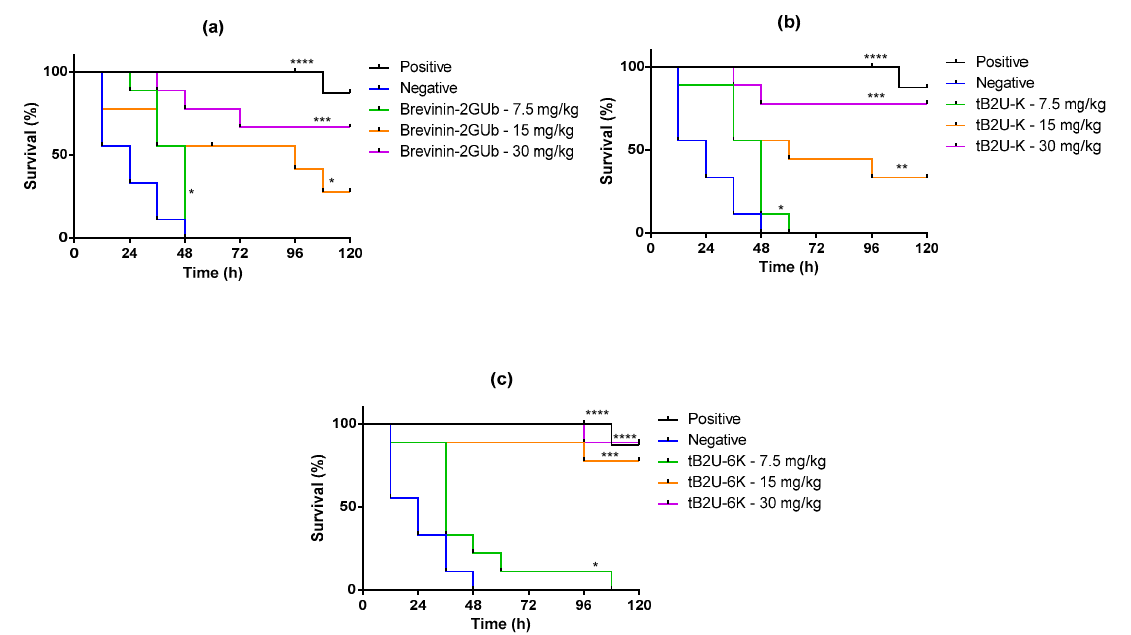
Figure 9. The curves of survival of ( a ) Brevinin-2GUb, ( b ) tB2U-K, and ( c ) tB2U-6K in wax moth infected by E. coli . The PBS and 20 mg/kg norfloxacin are selected as the negative and positive controls, respectively. The data were analysed by the survival analysis and curve comparison test comparing the survival rate of different concentrations of peptides with that of the negative control group. The significance (Table S3) is indicated by the **** ( p < 0.0001), *** ( p < 0.001), ** ( p < 0.01), and * ( p < 0.05).